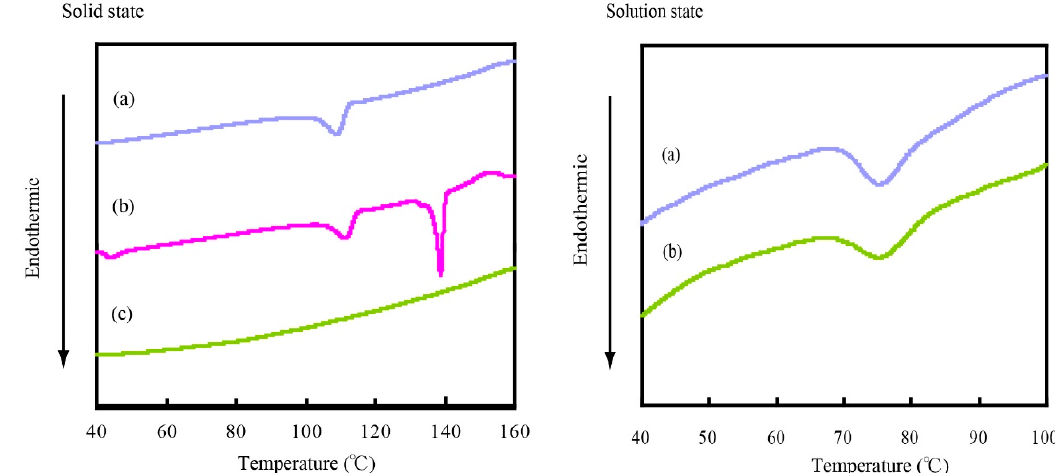
Figure 2. Di ff erential-scanning calorimetry (DSC) thermograms of each lysozyme in solid state (left) and solution state (right). Solid state: ( a ) lysozyme, ( b ) physical mixture of lysozyme and cholesterol (lysozyme [mol] / cholesterol [mol] = 1 / 12) and ( c ) CHLysozyme. Weight of each sample: 5 mg. Solution state: ( a ) lysozyme, and ( b ) CHLysozyme. Lysozyme and CHLysozyme concentration: 30 mg / mL.